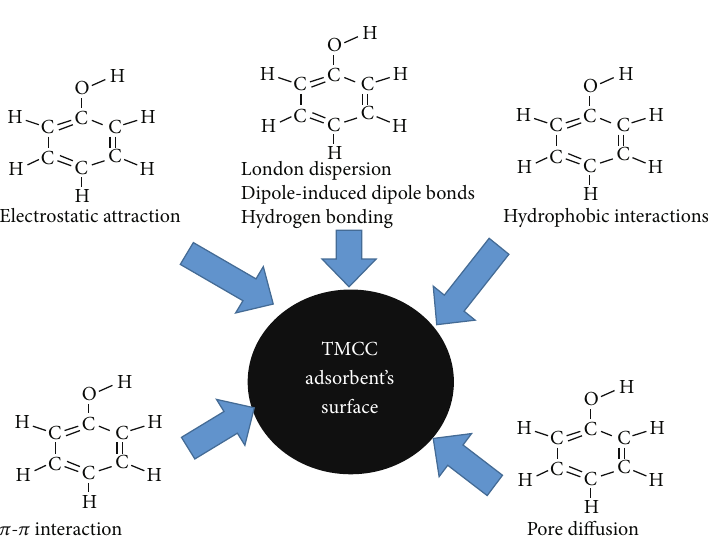
Figure 6: Summary of the adsorption mechanism of phenol onto TMCC at optimum